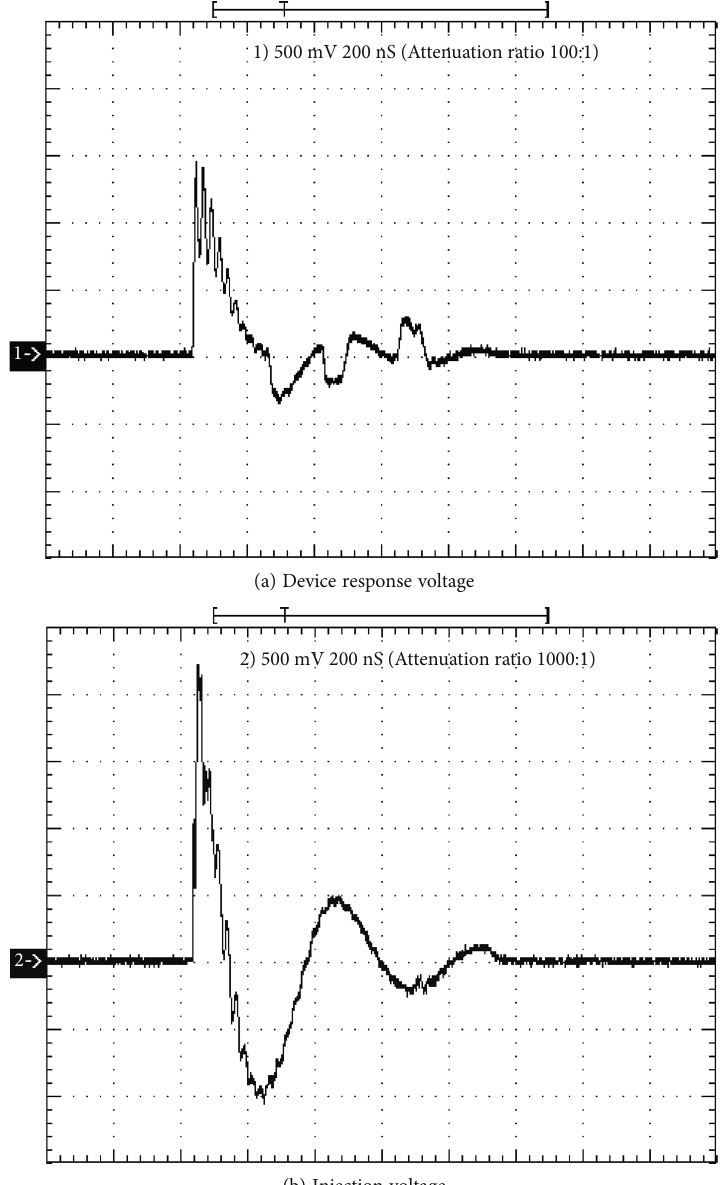
Figure 8: Response waveform of TVS to narrow